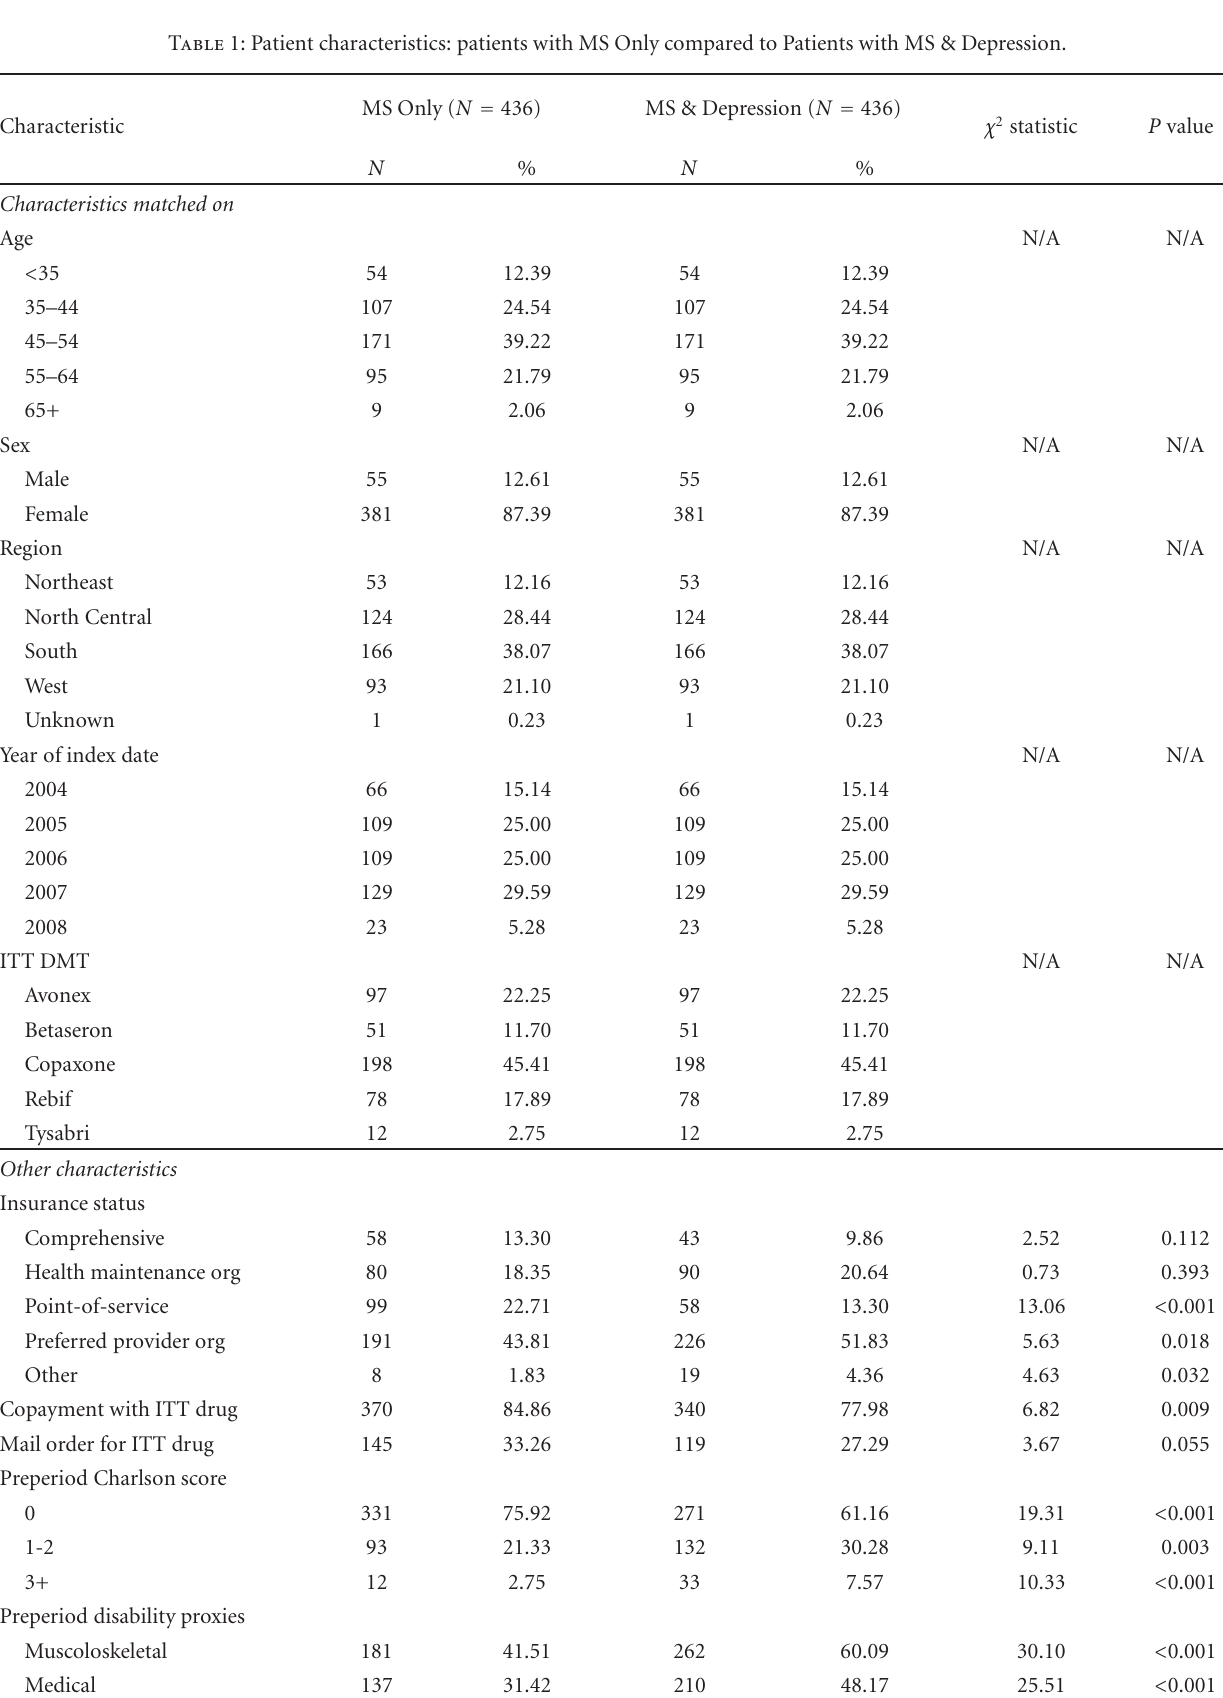
Table 1: Patient characteristics: patients with MS Only compared to Patients with MS &